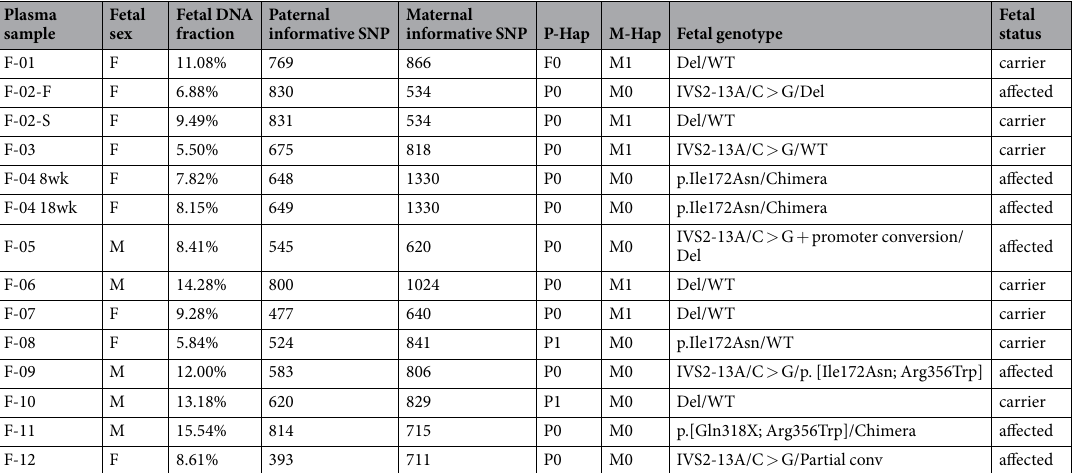
Table 3. Determination of fetal sex, fetal DNA fraction, and fetal haplotype in each family. Abbreviantions: Paternal informative SNP: SNP that was uniquely identified in one paternal haplotype; Maternal informative SNP: SNP that was uniquely identified in one maternal haplotype; Pat-Hap, paternal inherited haplotype; Mat-Hap, maternal inherited haplotype; P0, paternal haplotype linked with pathogenic mutation; P1, paternal haplotype linked with wild-type allele; M0, maternal haplotype linked with pathogenic mutation; M1, maternal haplotype linked with wild-type allele; WT: wild-type